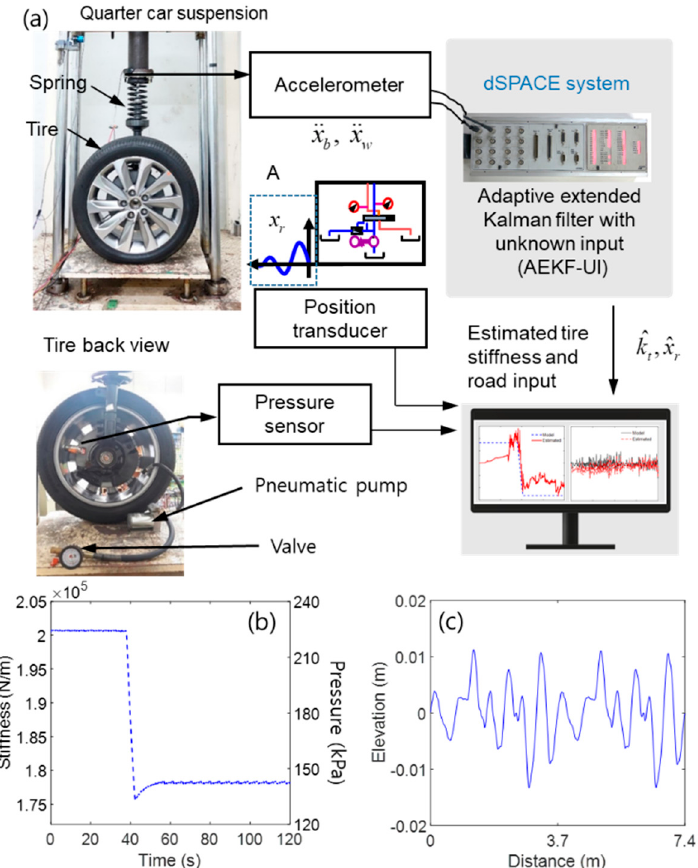
Figure 11. Experimental setup for indirect pressure measurements; ( a ) schematic diagram with photographs of quarter-car test-bed, ( b ) measured pressure drop scenario and ( c ) excited road roughness input (vehicle speed of 20 km/h).